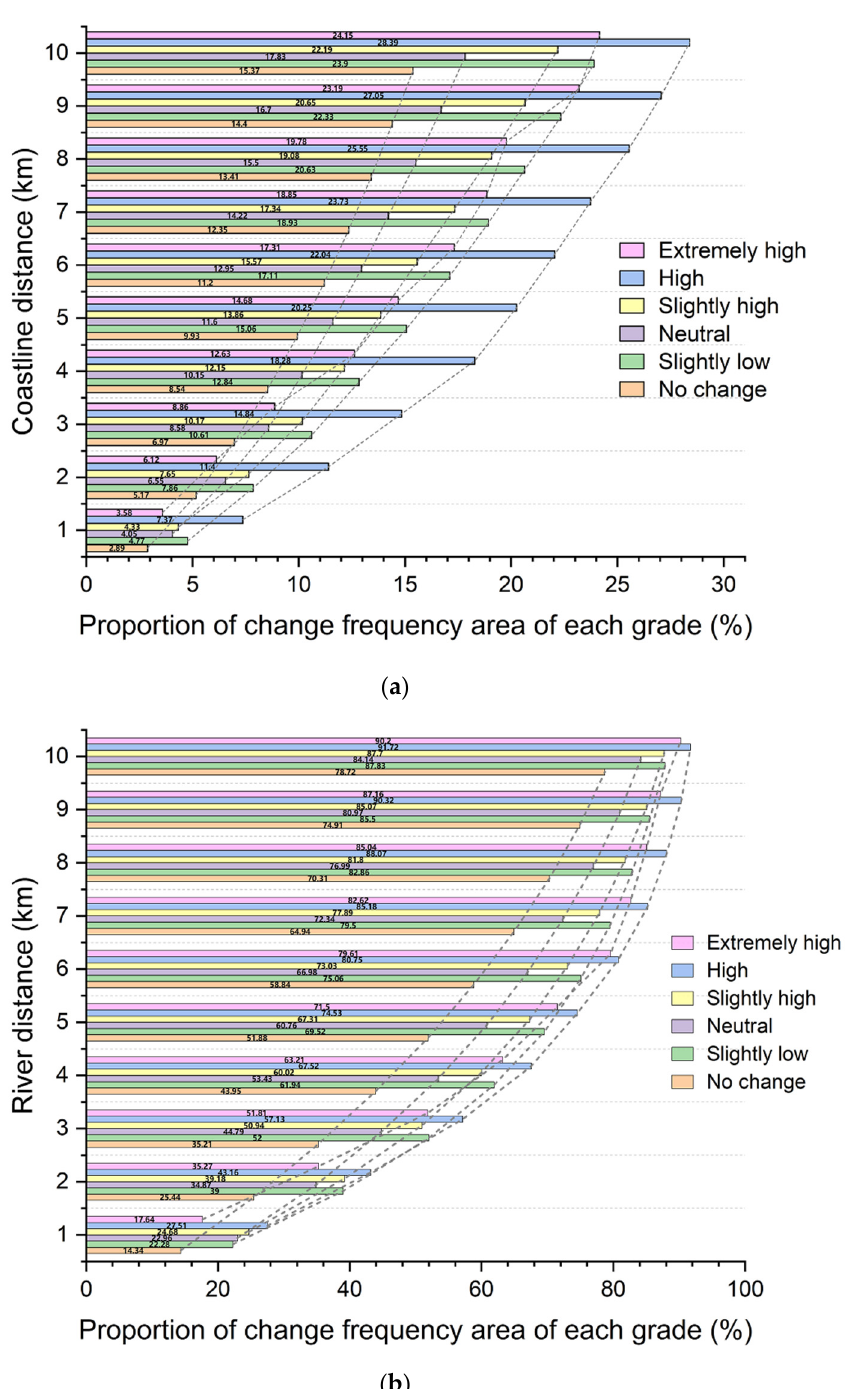
Figure 6. Area proportion of land-use-change frequency for each class within a 10 km buffer zone of the coastline ( a ) and the river ( b ).